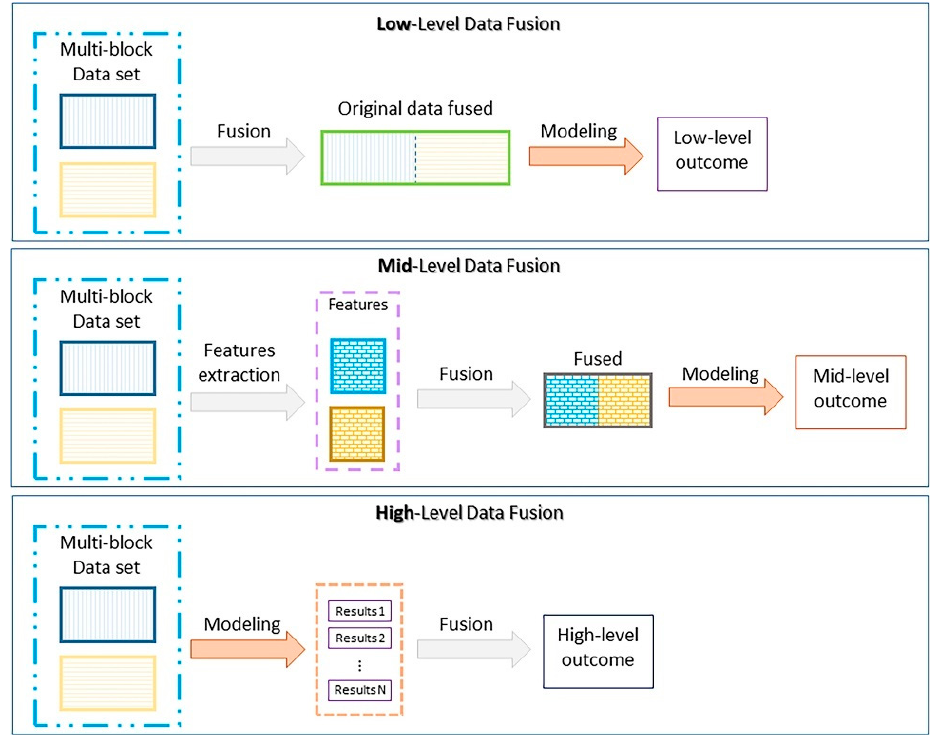
Figure 8. General scheme depicting the main differences among low-, mid-, and high-level data fusion. Reproduced with permission from [118] without modification. Copyright 2019 Elsevier.